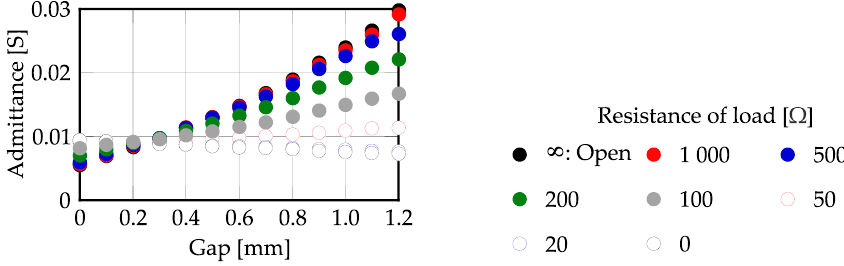
Figure 19. Relationship between gap and admittance at the driving frequency for various load re- sistances.